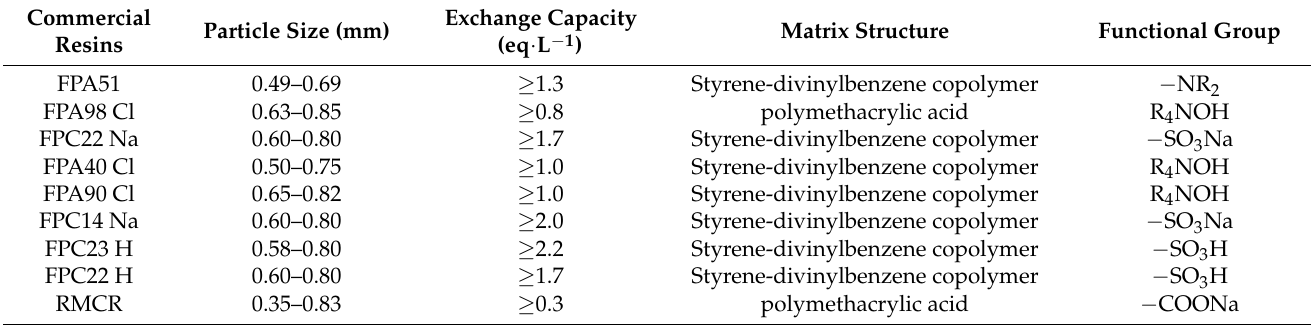
Table 3. Physicochemical properties of the commercial resins used.